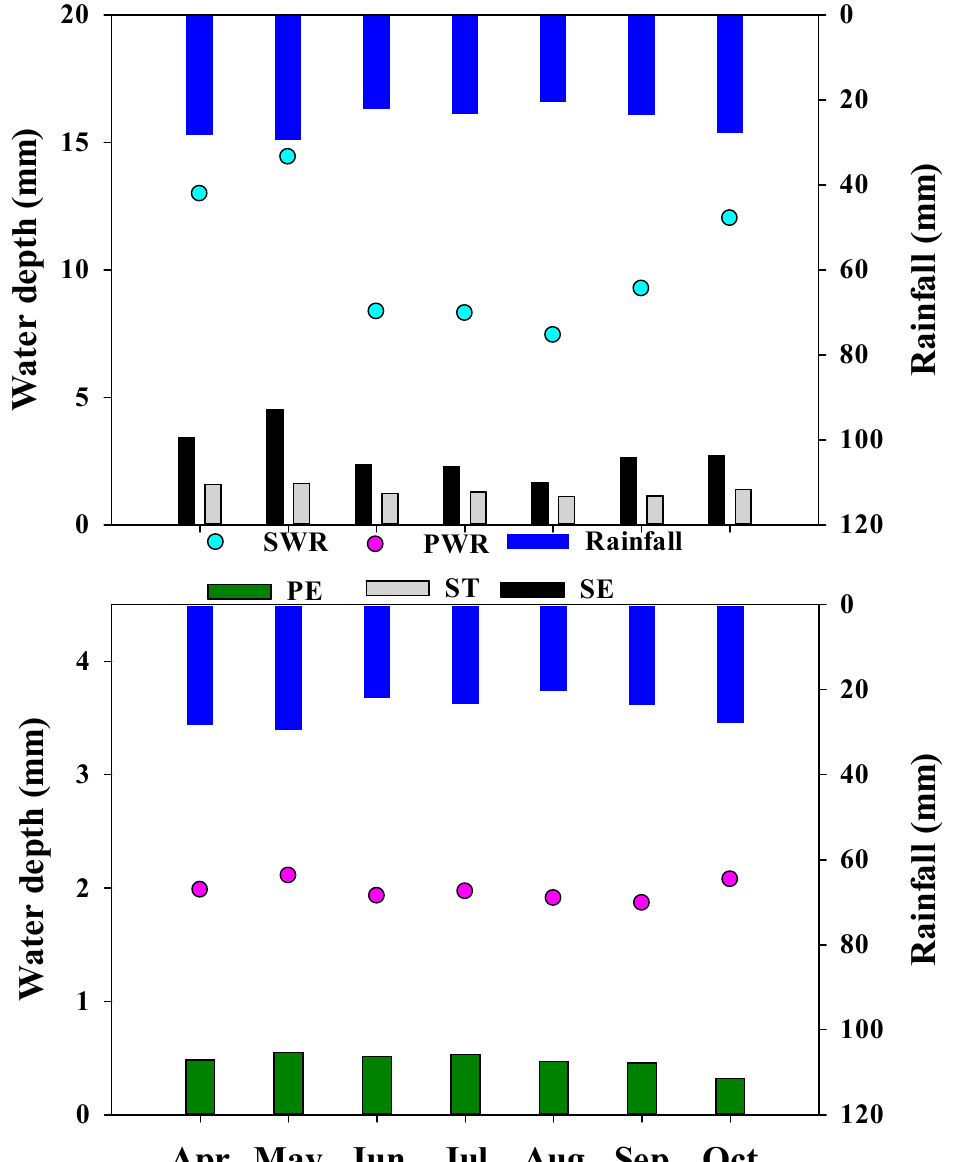
Figure 2. Weekly rainfall, stream water resources (SWR), stream evaporation (SE) and stream transmission (ST), pond water resources (PWR), and pond water evaporation (PE) from April to October in Big Sunflower River Watershed.